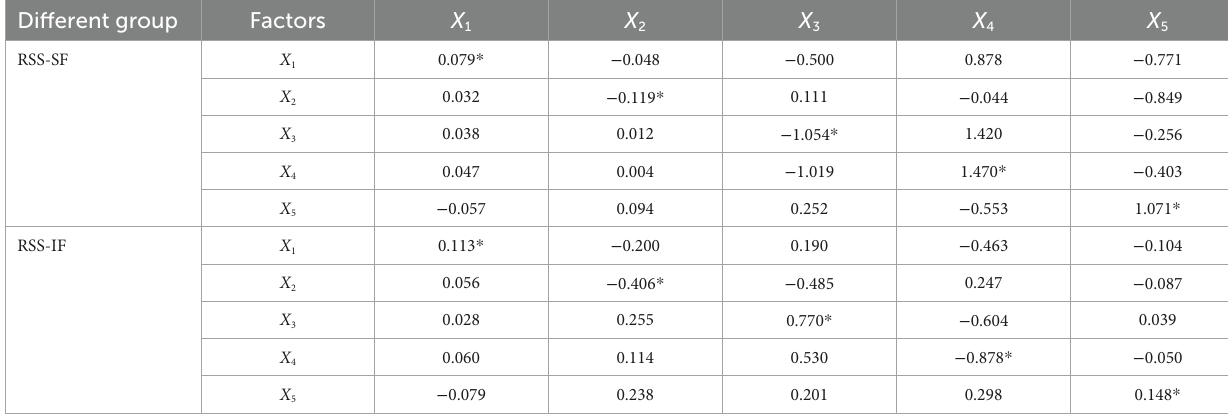
TABLE 2 Path analysis in group RSS-SF and